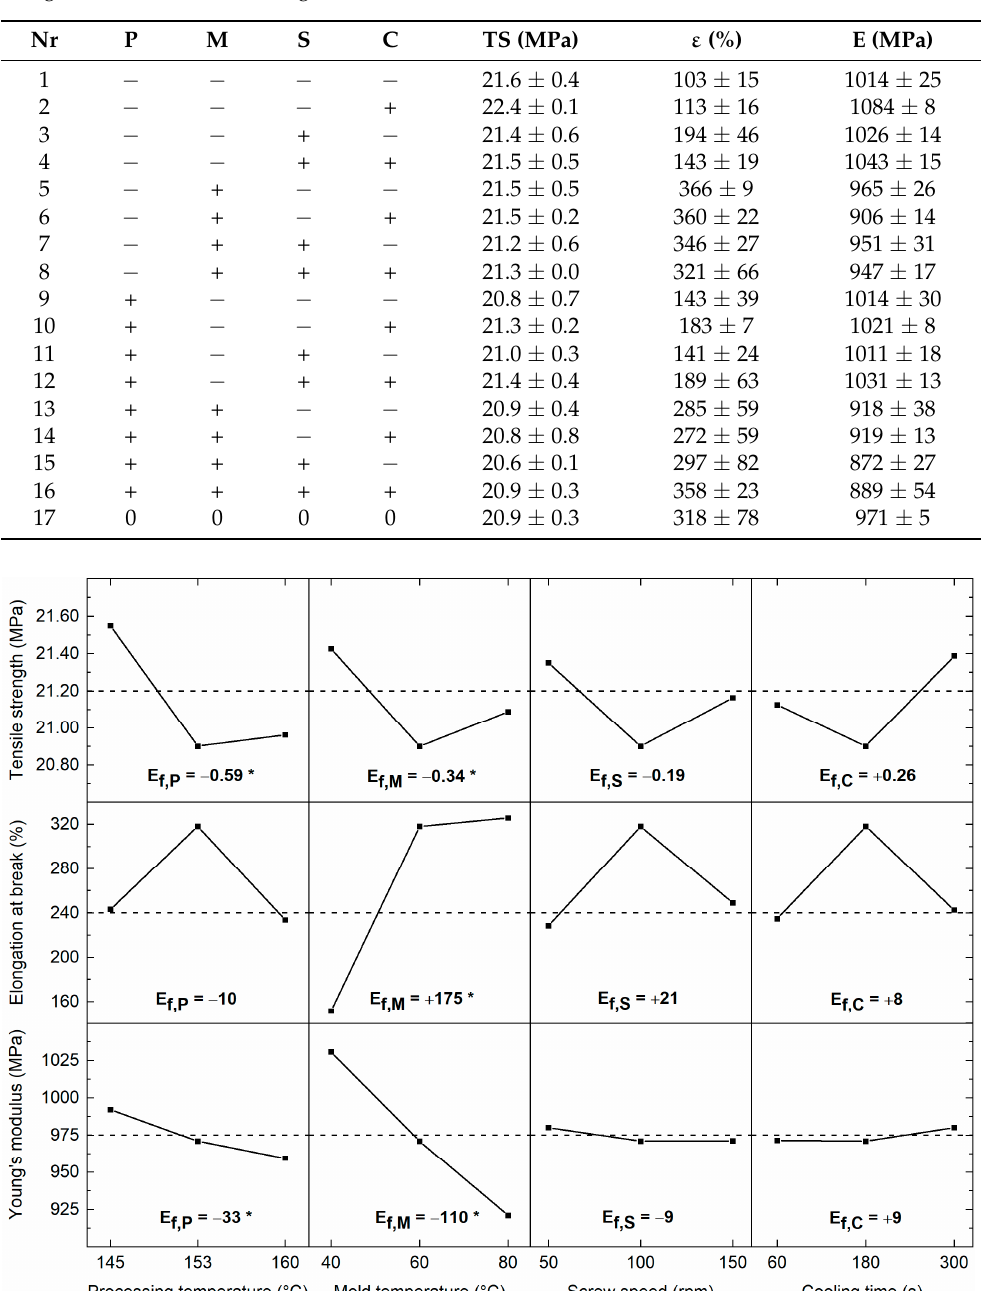
Figure 3. Main effects plot for tensile strength (TS), elongation at break ( ε ), and Young’s modulus (E) showing average values across the FFD matrix for the parameters M , P , S, and C . Significant main effects E f,X are indicated with an asterisk.